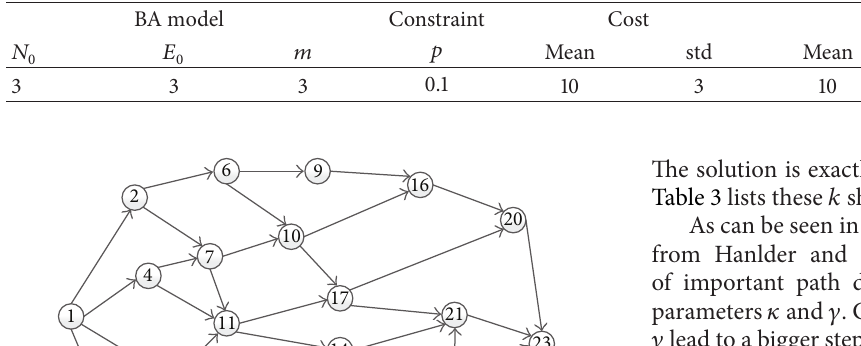
Table 4: Setting parameter values.